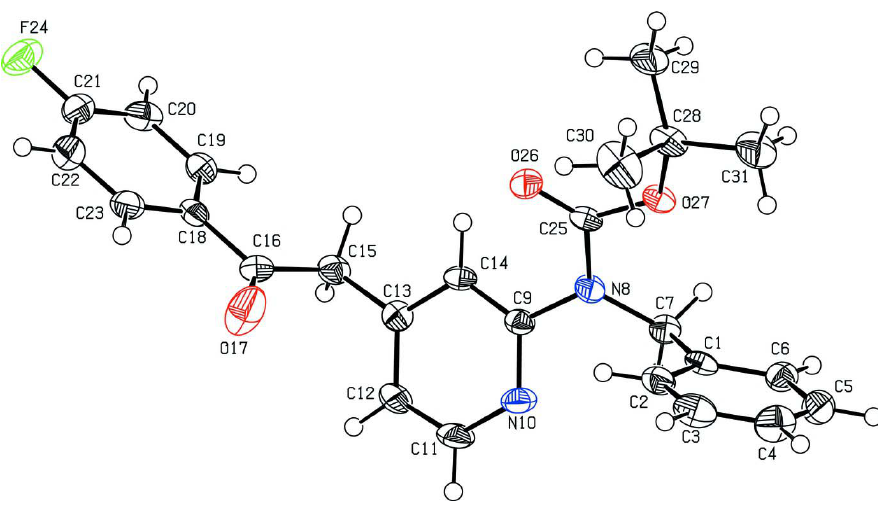
Figure 1 View of compound I . Displacement ellipsoids are drawn at the 50% probability level. H atoms are depicted as circles of arbitrary